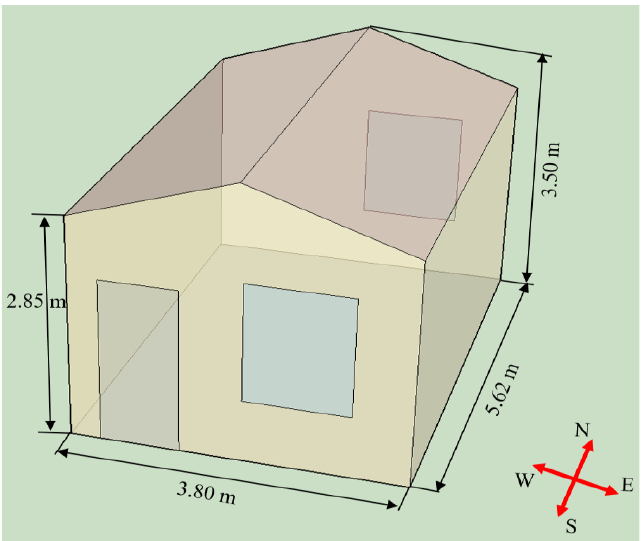
Figure 9. Schematic diagram of the prefabricated temporary house. Table 5. Structural details of prefabricated temporary houses.